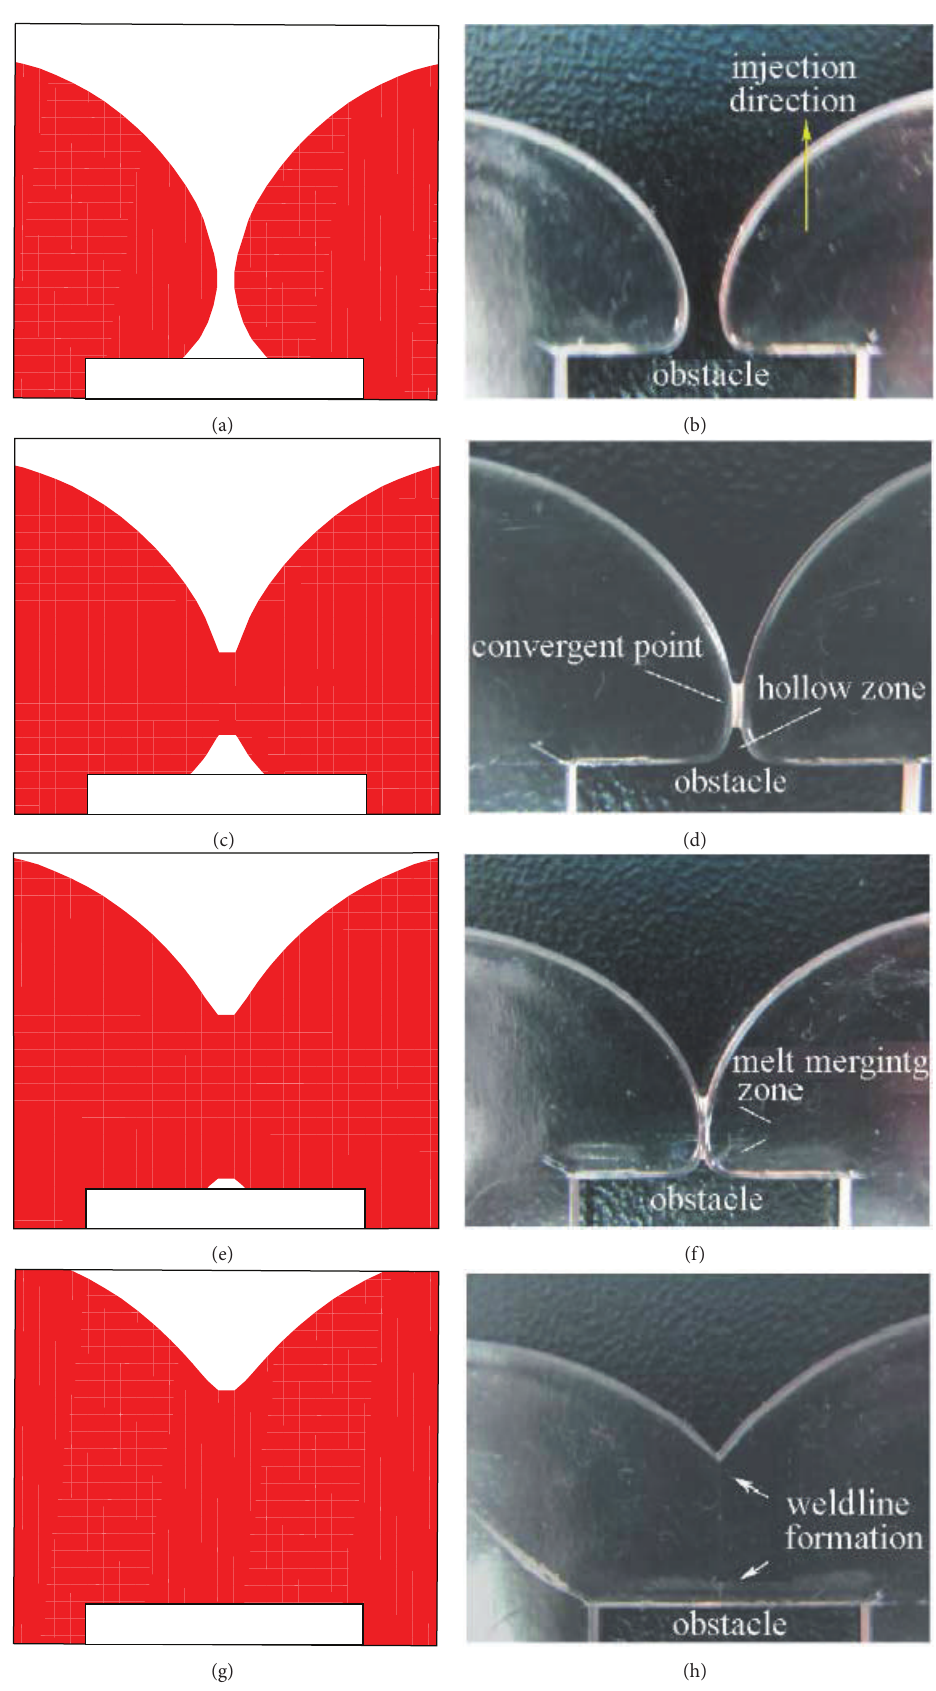
Figure 4: Comparison between the interface evolution after the insert and that obtained in